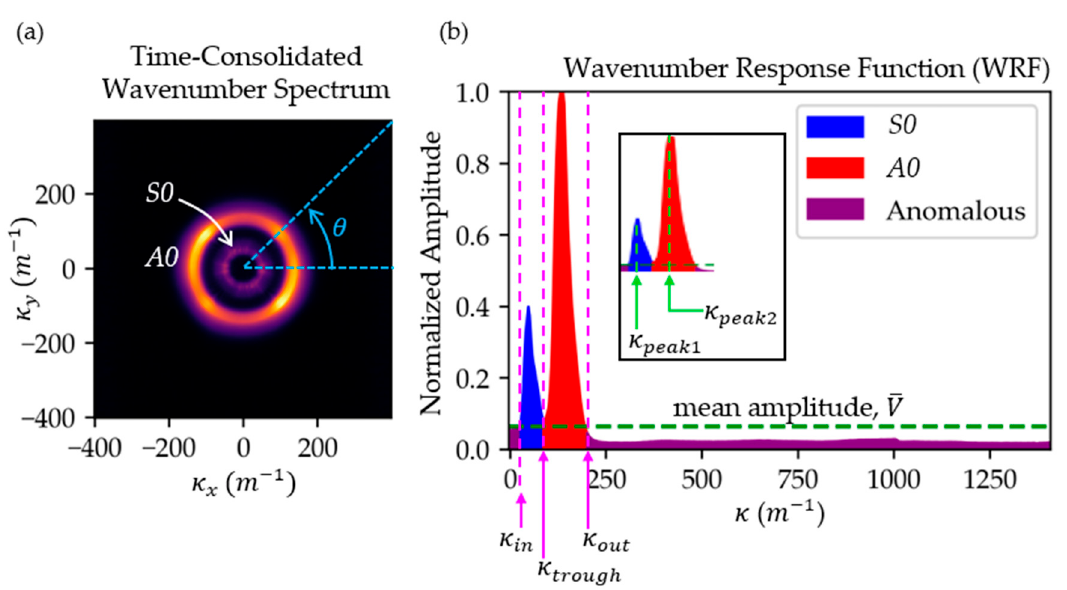
Figure 3. Graphical definition of κ in , κ out , and κ trough . ( a ) The time-consolidated wavenumber spectrum (TCWS) plot of a 2 mm steel plate (specimen of experiment Case P1). ( b ) The wavenumber response function (WRF) generated by consolidating the TCWS along the angular direction θ . The κ trough is located at the trough between the S0 and A0 modes, while the κ in and κ out are located at the mean-crossing positions of the WRF.